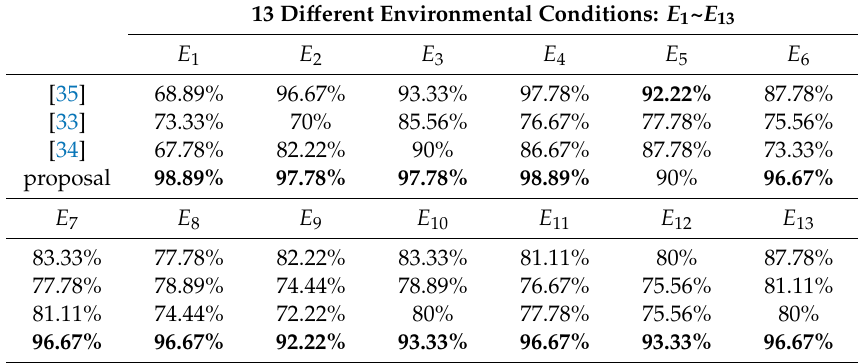
Table 6. Accuracy of di ff erent fault diagnosis strategies under 13 di ff erent environmental conditions ( E 1 to E 13